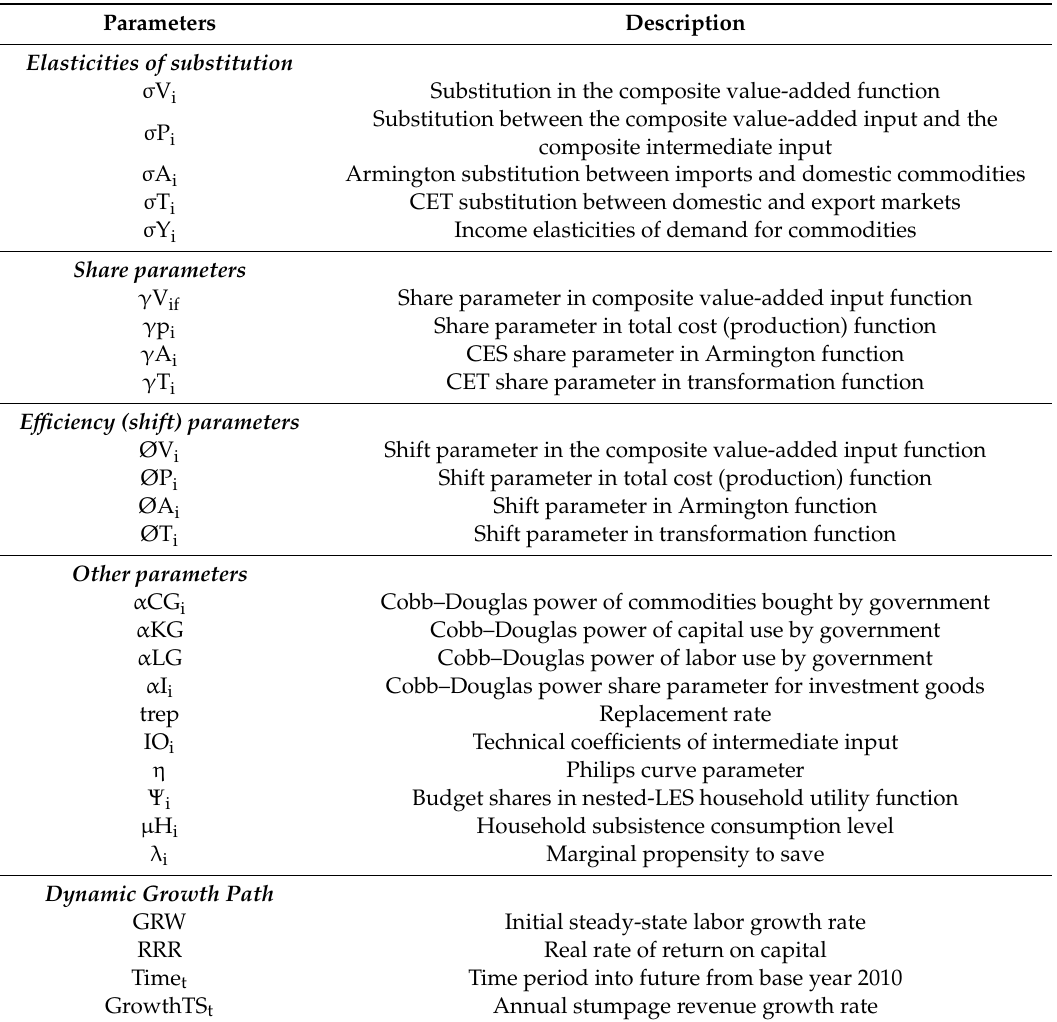
Table A2. CGE model